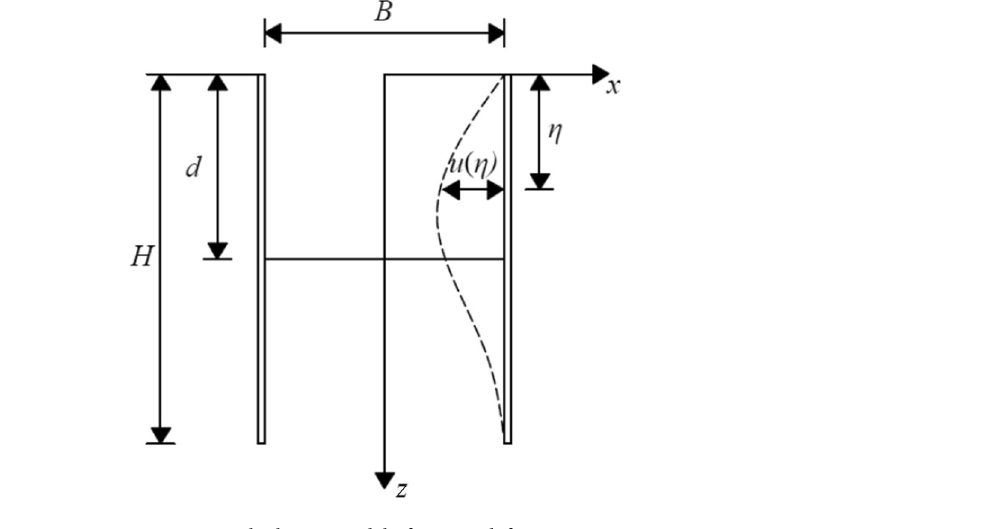
Figure 4. Calculation model of convex